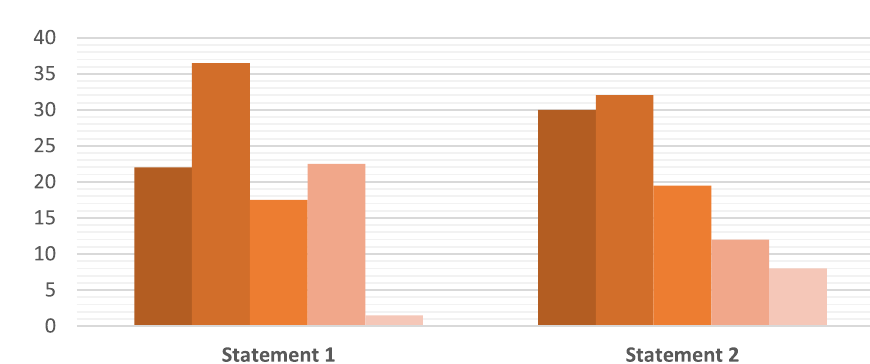
Fig. 14 Frequency, percentage on statement regarding the ways radio stations can kindle the use of English language in